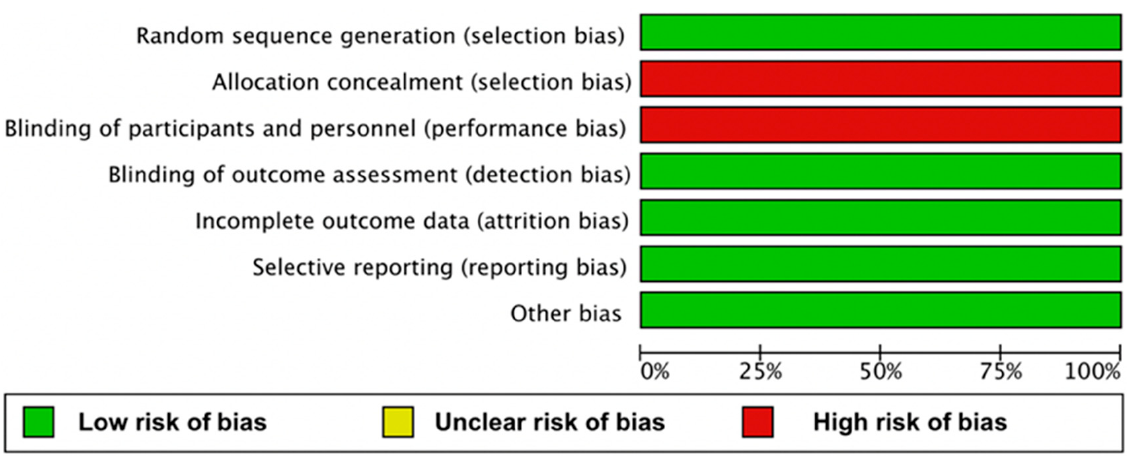
Figure 1. Risk of bias graph; authors’ judgments about each risk of bias item are presented as percentages across all included studies.